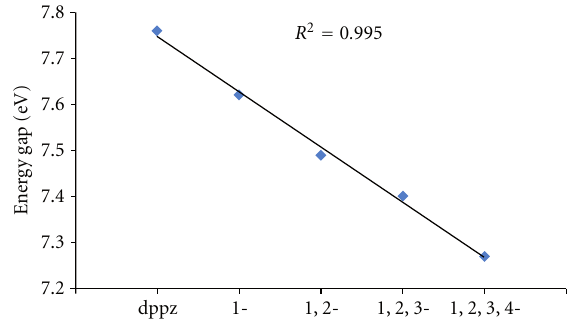
F 3: e plot of energy gap (LUMO-HOMO) (eV) for dppz, and 1-, 1,2-, 1,2,3-, and 1,2,3,4-chlorosubstituted